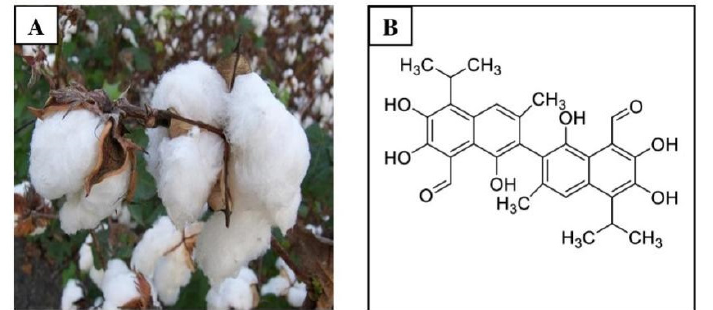
Figure 1. Gossypol profile: ( A ) cotton plant ( Gossypium hirsutum L.) ( B ) structure of gossypol.